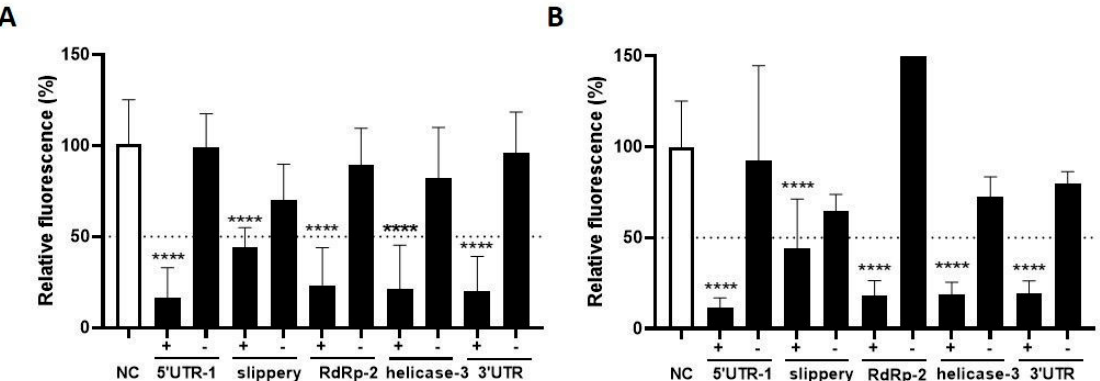
Figure 6. The efficiency of crRNAs targeting SARS-CoV-2 and SARS-CoV replicon. ( A ) The efficiency of five selected single crRNAs targeting SARS-CoV-2 sequences was tested in HEK293T cells by co-transfecting them with a SARS-CoV-2 replicon. crRNAs targeting both SARS-CoV-2 + and − RNA sequences were included. Viral RNA replication was quantified by measuring levels of mNeonGreen. Mean values (±SD) of three experiments in duplicates are shown. The average mNeonGreen levels are expressed as percentage (%) of fluorescent cells, setting the negative control (NC) at 100%; ( B ) The same experimental set-up was used with a SARS-CoV replicon. Here, viral RNA replication was quantified by measuring levels of GFP. Statistical significance was determined using one-way ANOVA, **** p ≤ 0.0001.